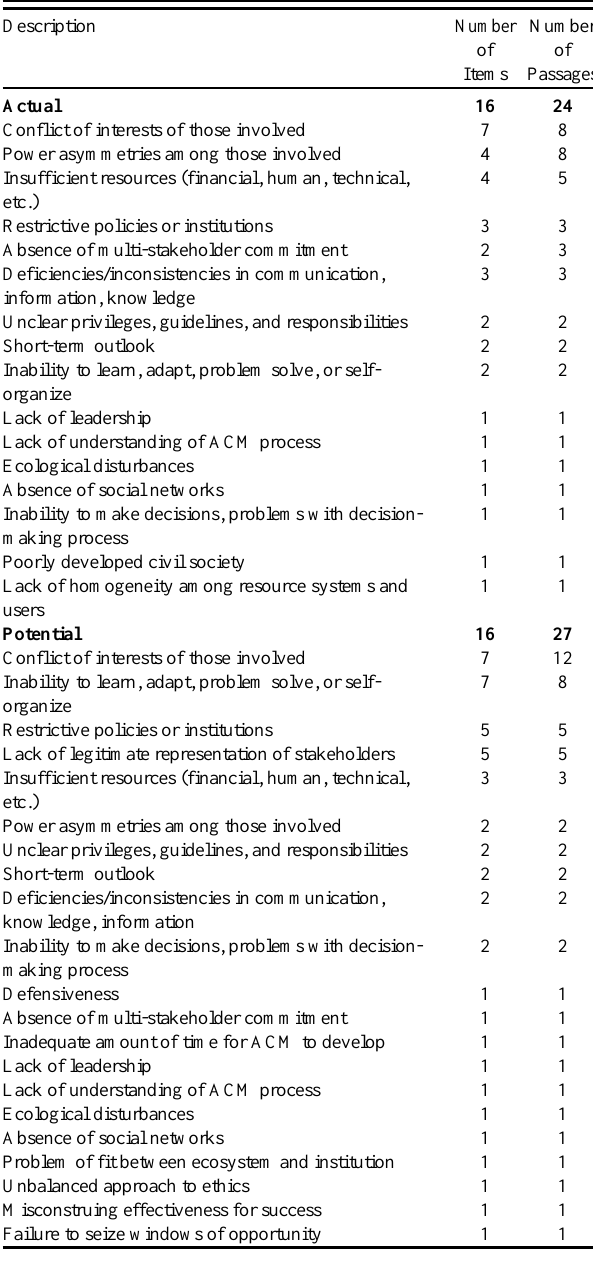
Table 8 . Factors Contributing to Failures of Adaptive